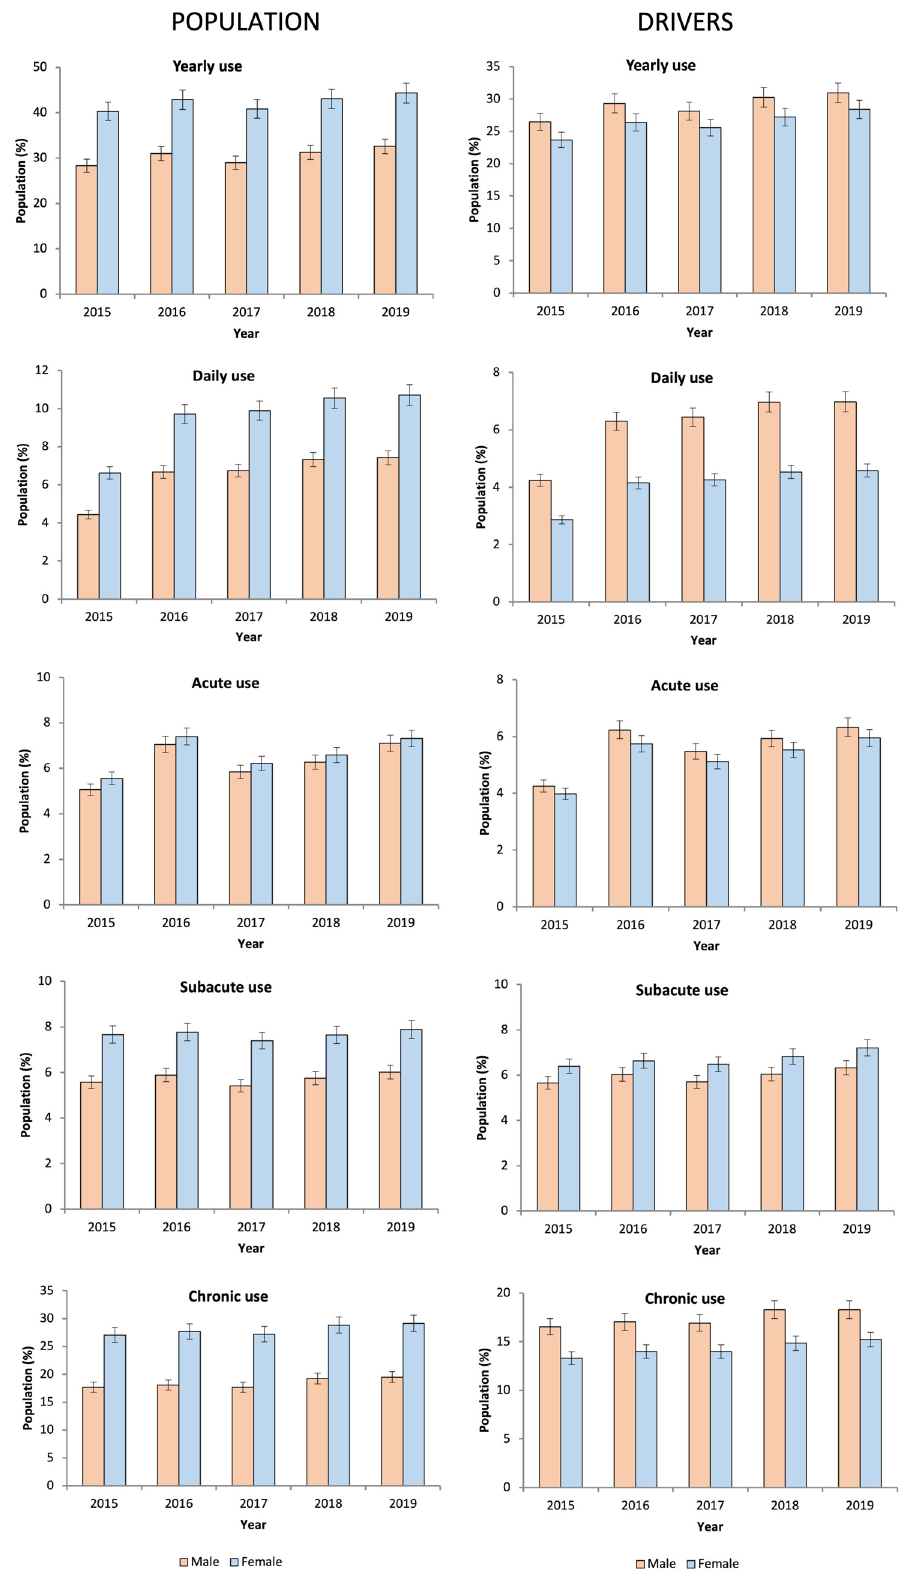
Figure 2. Evolution of the use of DIMs in Castile and Leon by the frequency of use (2015–2019). The yearly use of DIMs increased by approximately 12% (38.60% in 2019 vs. 34.41% in 2015, p = 0.001), with a particular impact on acute use, which increased by